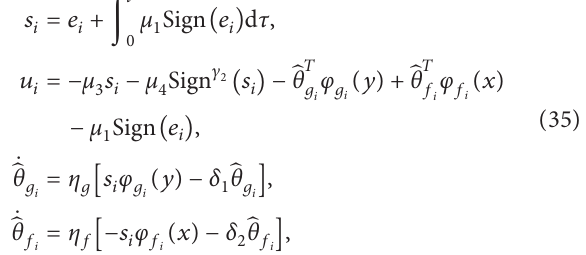
Figure 4: The trajectories of (a) sat ( u period [5 s,